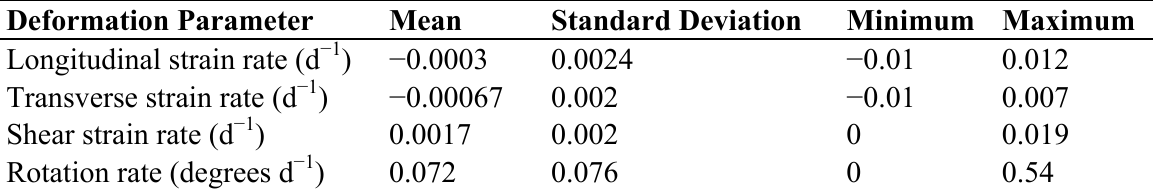
Table 6. Summary statistics of the computed deformation parameters of the Nigardsbreen glacier section.